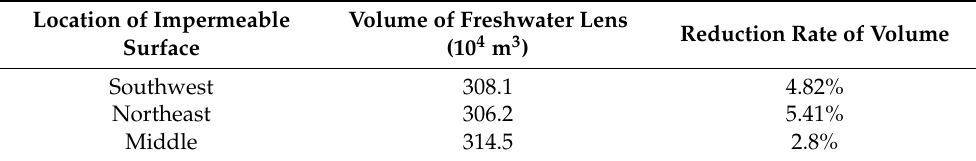
Table 2. Volume of the freshwater lens and its reduction rate under different conditions compared to the initial scenario.